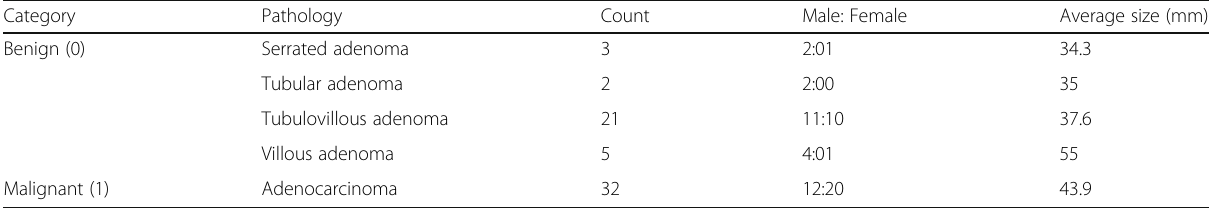
Table 2 Polyp masses dataset used for experiments